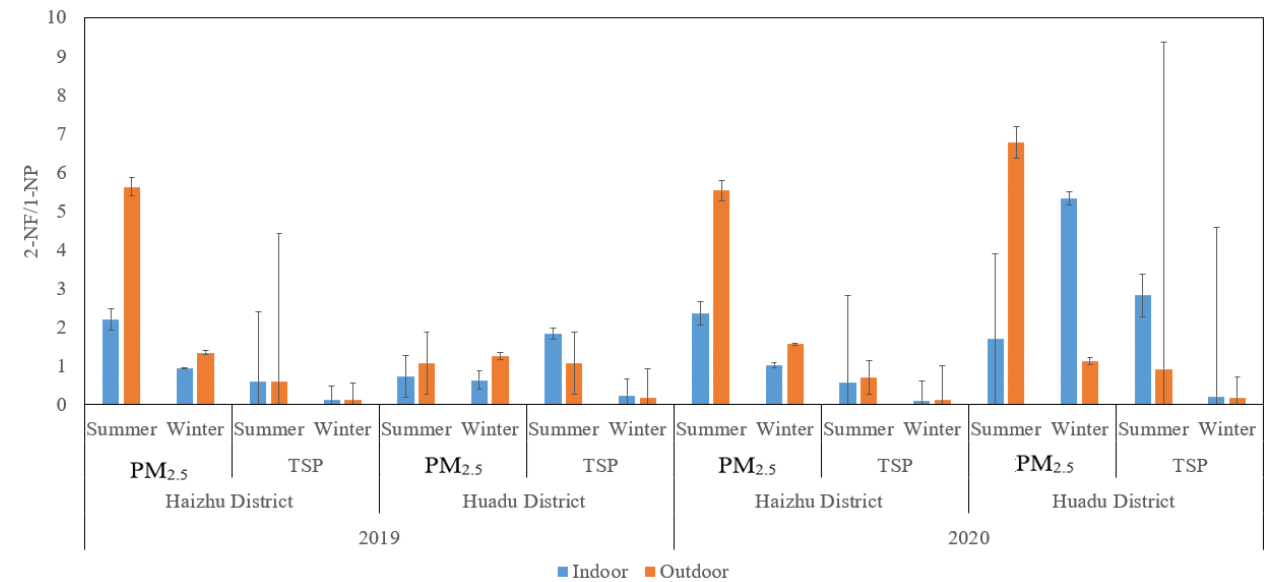
Figure 2. The diagnostic ratios of 2-NF/1-NP in PM 2.5 and TSP during the sampling period.